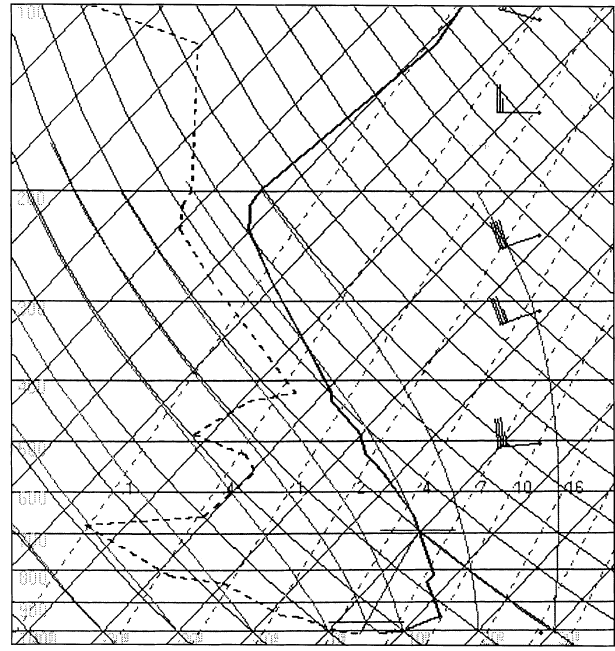
Fig. 3a,b. Time series during the prestorm and storm regimes of a daily precipitation totals (mm) over whole Segura Basin and b air pressure (hPa) at Murcia station